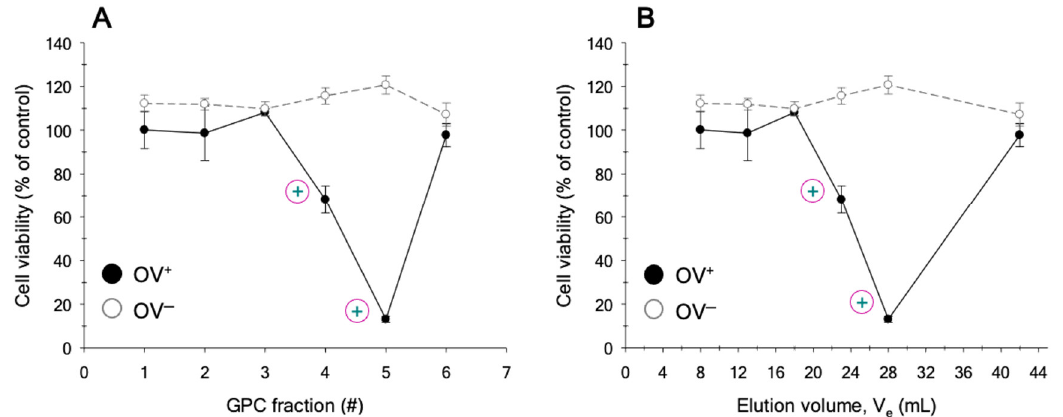
Figure 3. Example of the N2a toxicity profile after GPC at a concentration of 44 mg TE·mL −1 , corre- sponding to 10 mg TE·well −1 . Fraction ( A ) and elution volume (V e ) ( B ) vs. cell viability.